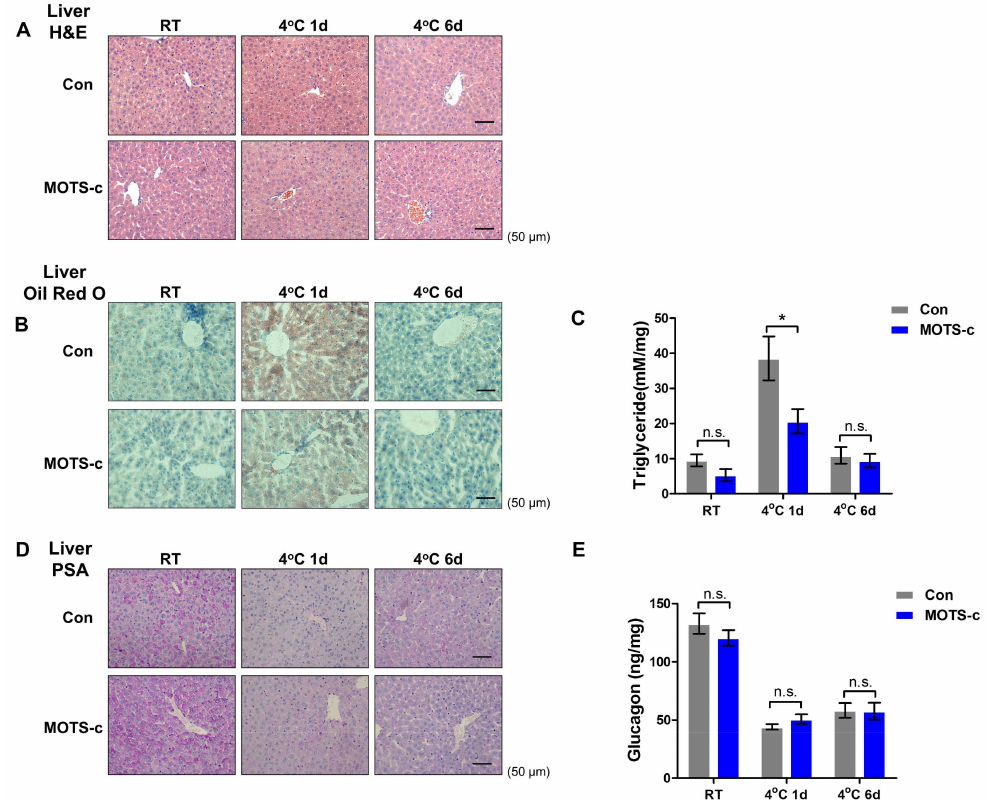
Figure 2. MOTS-c administration alleviates acute-cold-induced hepatic lipid accumulation. ( A ) H&E staining of the liver showing the morphologic change (scale bar = 50 µ m). ( B ) Oil Red O staining of the liver showing the lipid droplets (scale bar = 50 µ m). ( C ) Triglycerides content in the liver ( n = 8 per group). ( D ) PAS staining of the liver presenting the relative level of glycogen (scale bar = 50 µ m). ( E ) The glycogen content in the liver ( n = 8 per group). All data are represented as mean ± SEM. Di ff erences between the two groups were determined by a two-tailed Student’s t -test. * p < 0.05, n.s. = not